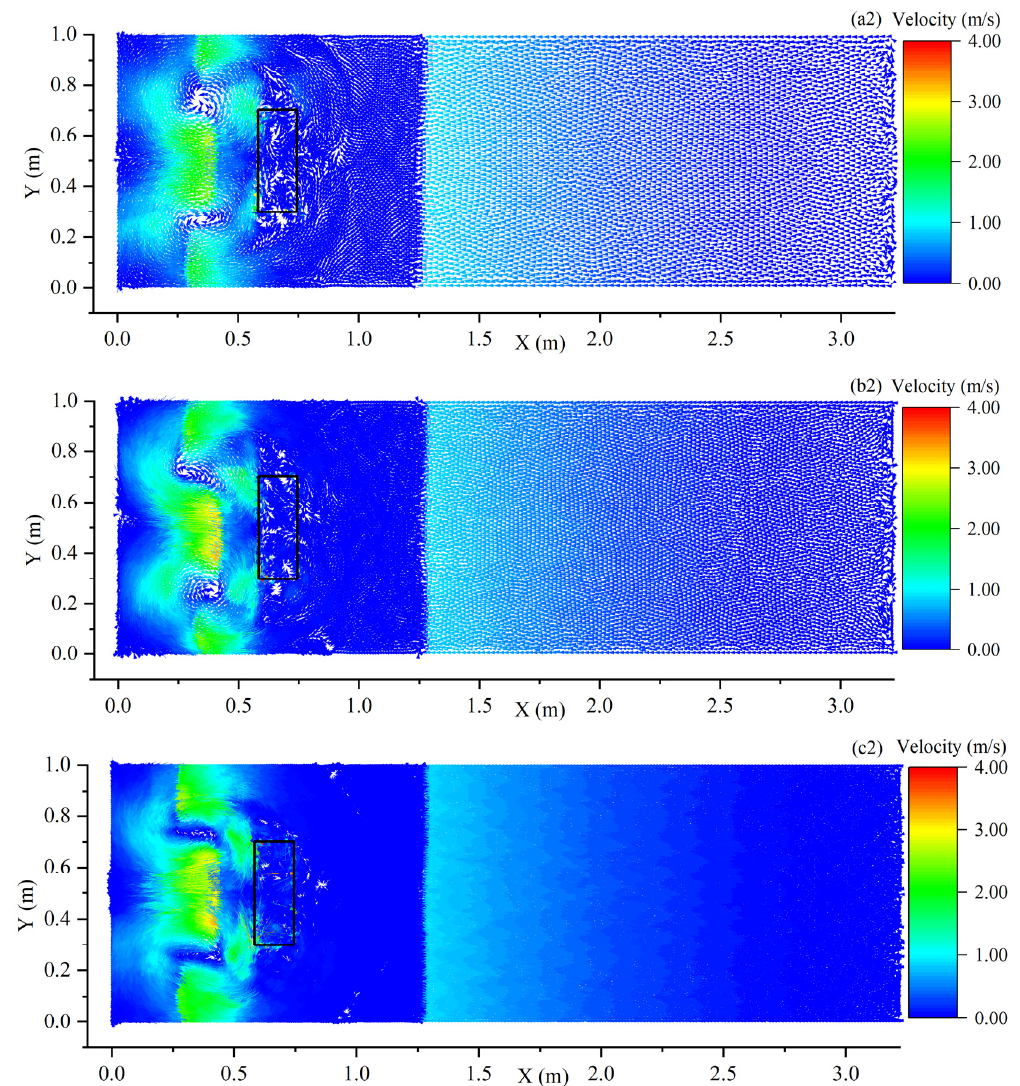
Figure 13. Velocity distribution at 1.76 s for Case 4 ( a2 ), 5 ( b2 ) and 6 ( c2 ) displayed in Table 6.